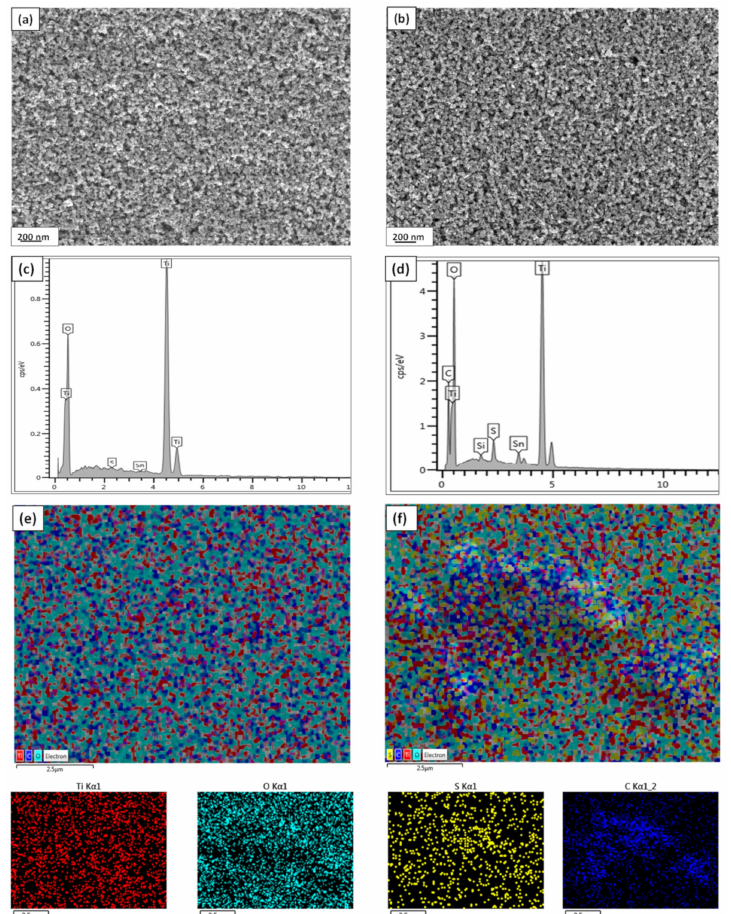
Figure 5. FESEM morphological images of the EDX elemental spectra and elemental mapping of Ti, O and S of the un-doped ( a , c , e ) and ( b , d , f ) S-doped TiO 2 .